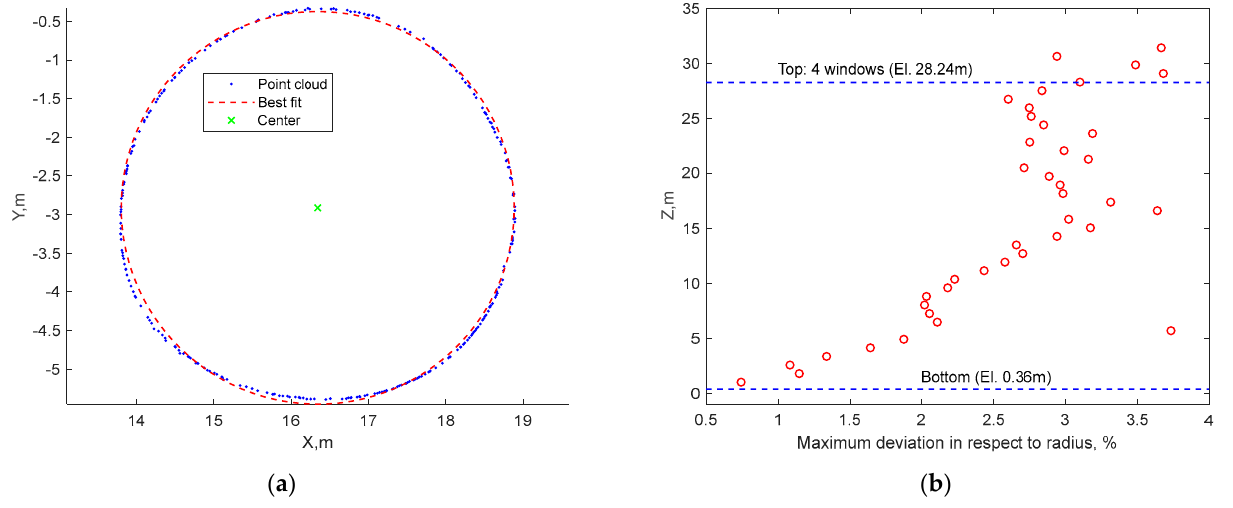
Figure 11. The proximity of the horizontal cross-sections to circles: ( a ) typical cross-section (elevation of 16.59 m) with a best fit circle; ( b ) normalized deviations over the elevation.